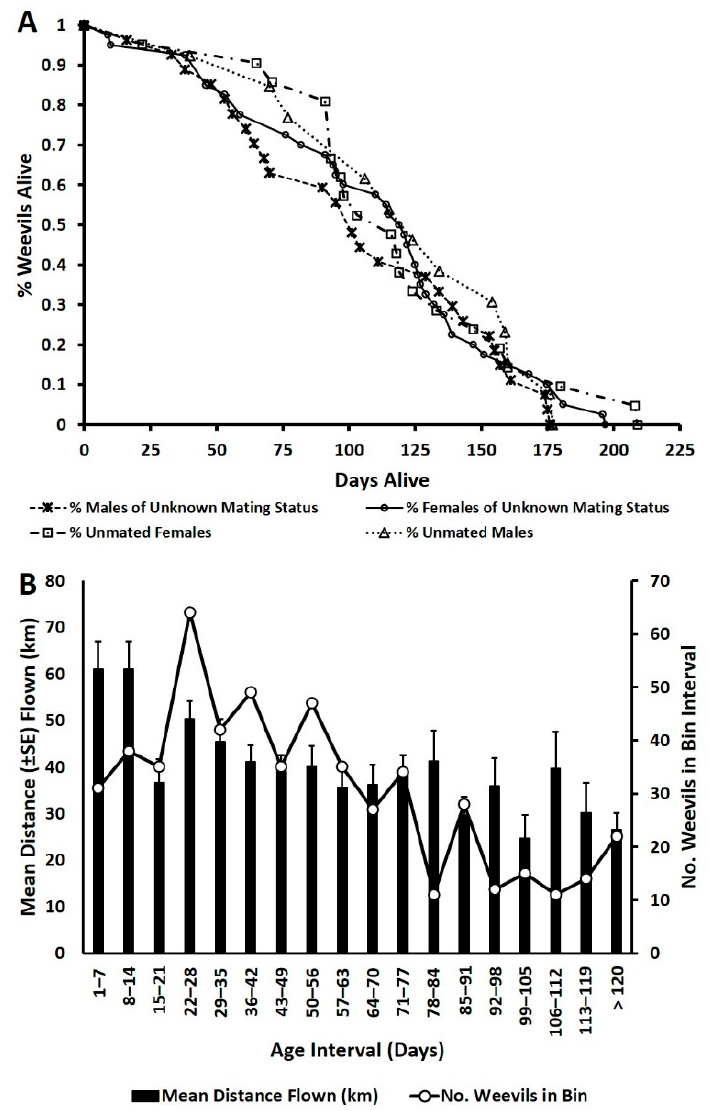
Figure 4. ( A ) Survivorship curves for adult Rhynchophorus palmarum used for flight mill trials. ( B ) Mean (+SE) distance flown (km) and number of weevils that flew >1 km in age interval bins. 3.2. Dispersal and Redistribution Kernels for R. palmarum Using Distance Flown Table 2. Lowest calculated RSS values fitted to equations for curves 1 and 3 from Kot et al. [1], parameter estimates and normalizing constants for curves 1 and 3, and measures of excess kurtosis for individual flights 1–9, combined flights 10– 14, and all flights combined (1–14). Flight Number